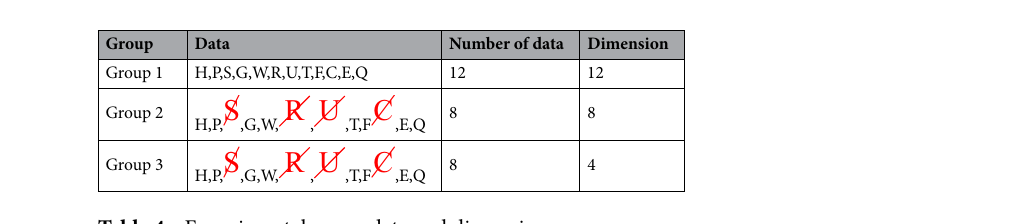
Table 4. Experimental group data and